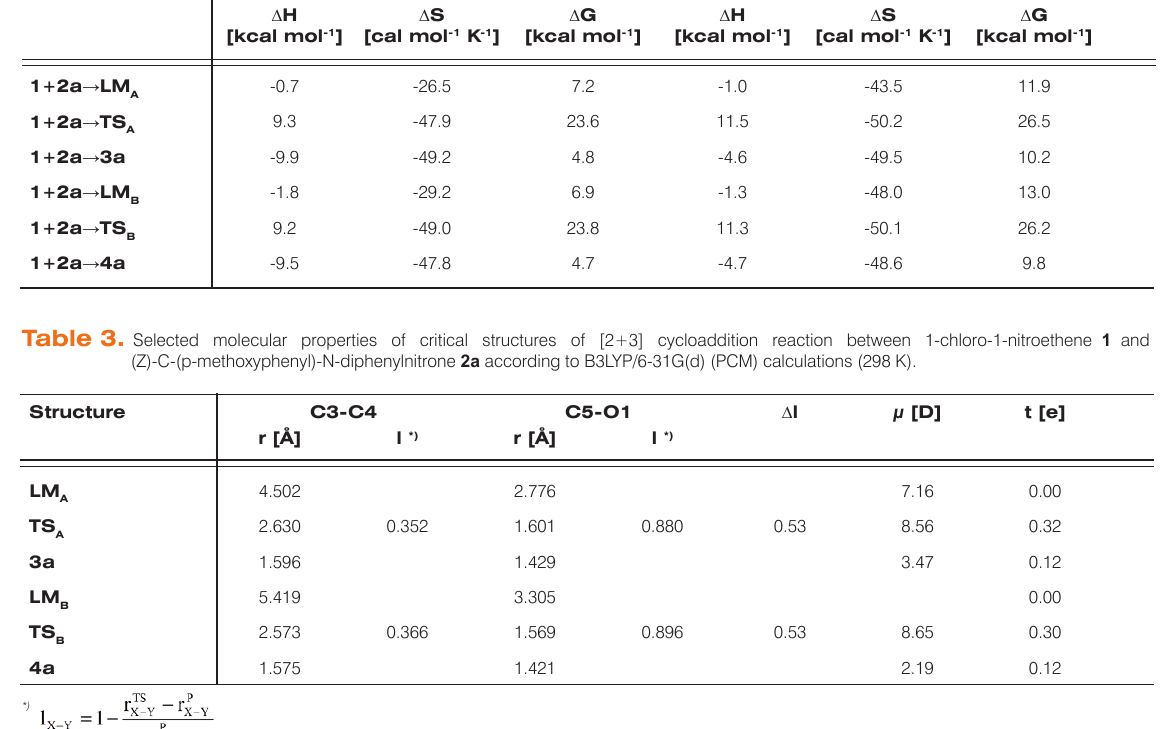
Table 2. Eyring parameters of [2+3] cycloaddition reaction between 1-chloro-1-nitroethene 1 and (Z)-C-(p-methoxyphenyl)-N-diphenylnitrone 2a according to B3LYP/6-31G(d) (PCM) and B3LYP/6-31+G(d) (PCM) calculations (298 K). Transition